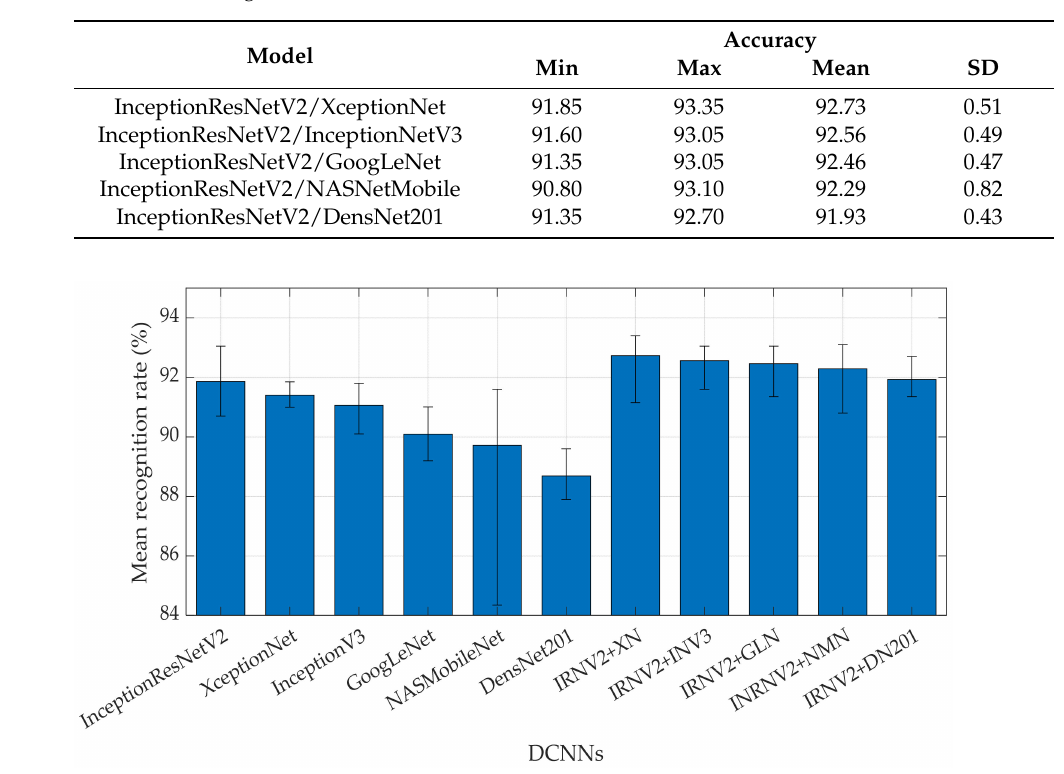
Figure 23. Object recognition using multimodal DCNNs. Table 7. The recognition rate of multimodal DCNNs.